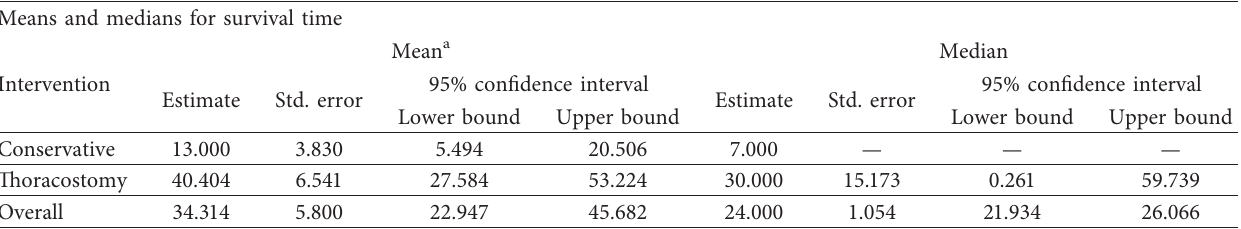
Table 4: Kaplan–Meier test for analysis of the survival rate in our sample regarding the management plan.